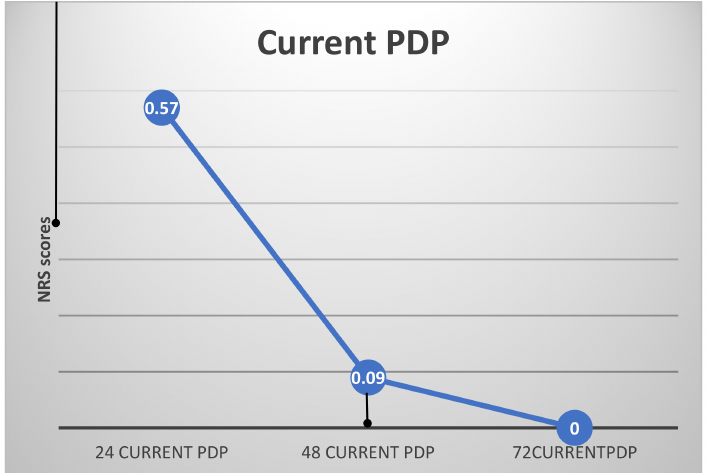
Figure 2. Current PDP (entire population) (mean NRS scores; vertical lines indicate standard